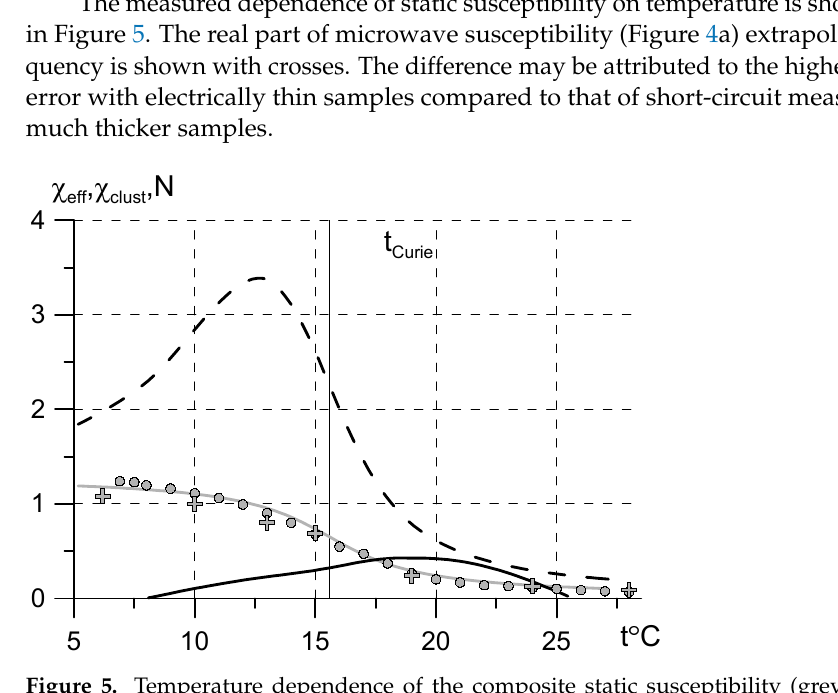
Figure 5. Temperature dependence of the composite static susceptibility (grey line), of cluster shape factor (solid black line), and of intrinsic susceptibility of cluster (dashed black line). The dots and crosses present the measured static susceptibility of the composite and the real part of microwave susceptibility (Figure 4a) extrapolated to zero frequency correspondingly; the lines present simulation data.